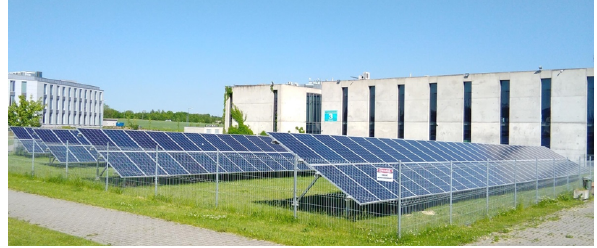
Figure 1: Photovoltaic plants in front of the building of the Lublin Science and Technology Park